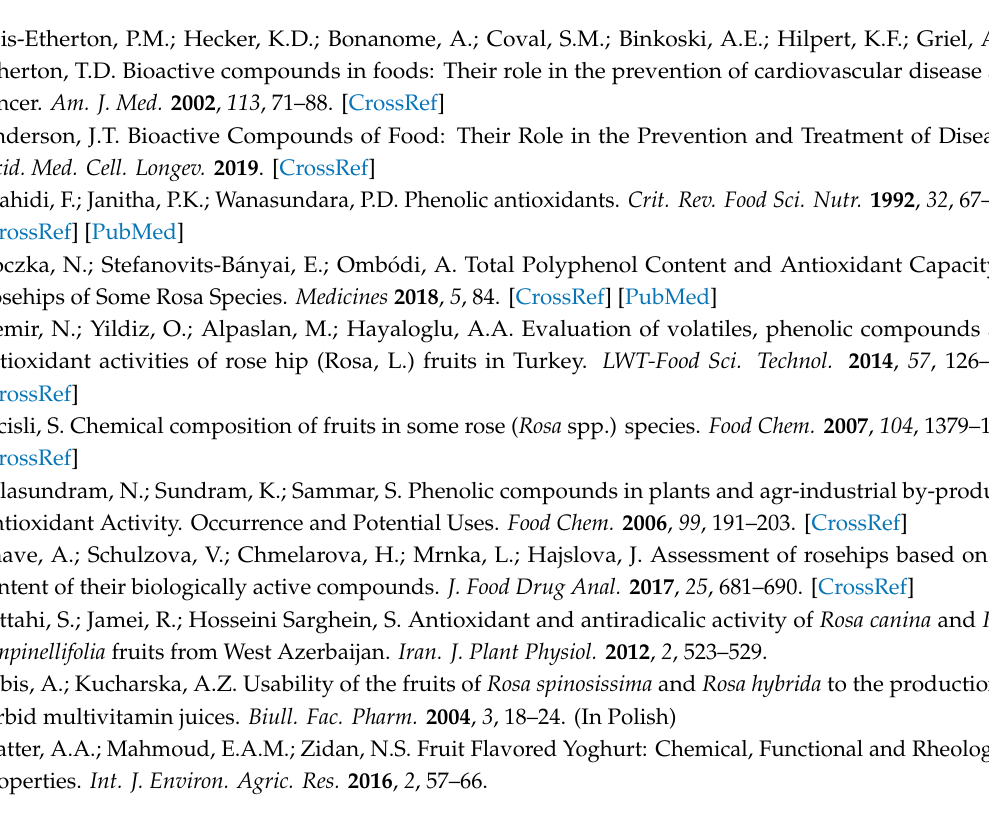
R, LOD, and LOQ data for four used